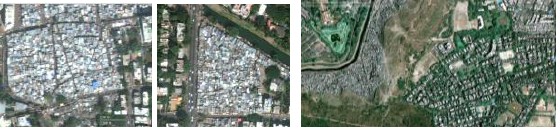
Figure 3. Location of Slums near canal and along the hill